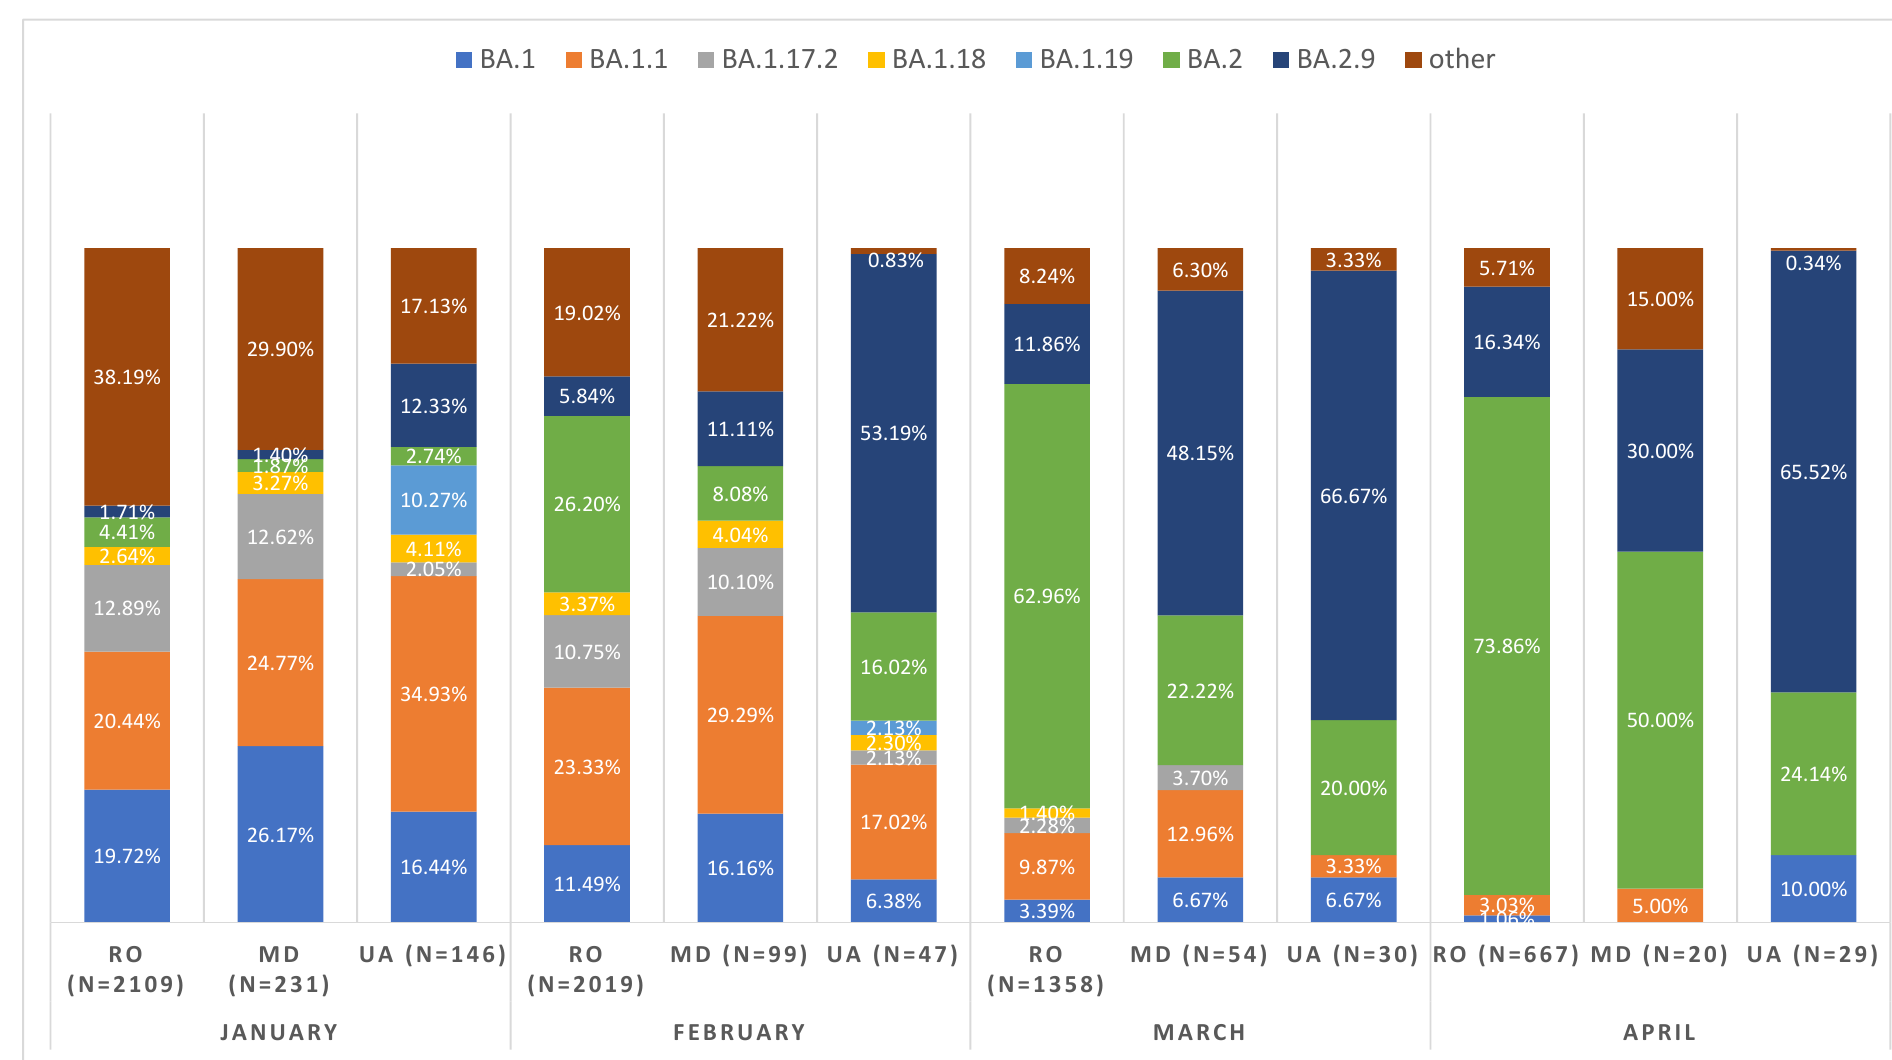
Figure 3. Monthly distribution of SARS-CoV-2 lineages in January-April 2022. (RO—Romania, MD—Moldova, UA—Ukraine).